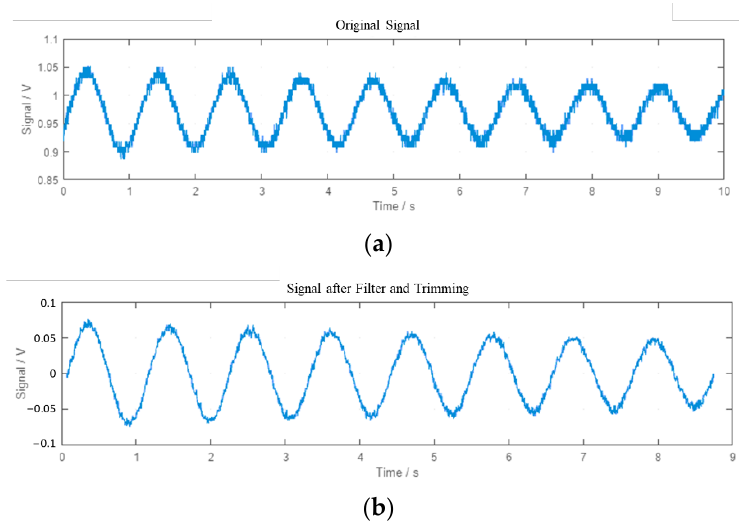
Figure 10. Plots of the signal in the different steps of the processing. ( a ) Raw signal. ( b ) Processed signal (filtered and trimmed).